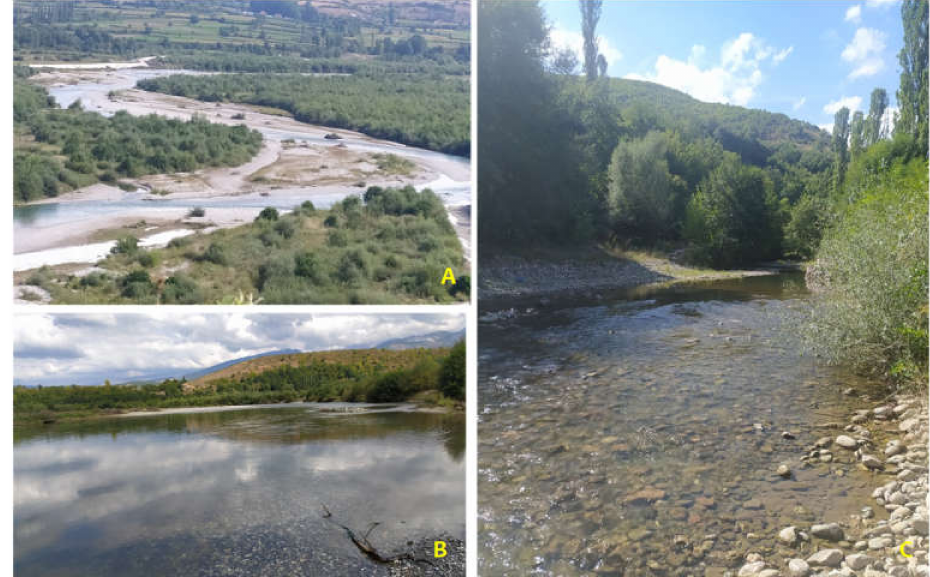
Figure 3. Fish sampling localities. ( A ) Fushe Cidhem; ( B ) Zall Rec and ( C ) Ujmisht.